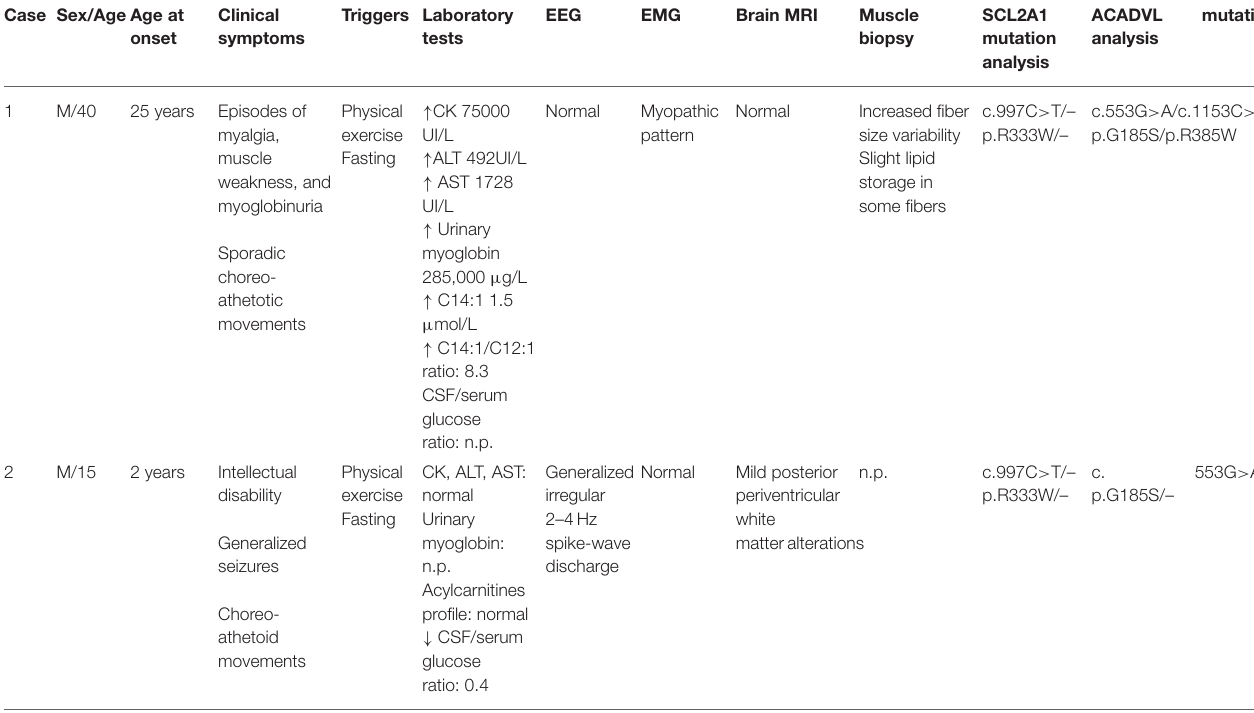
TABLE 1 | Clinical, biochemical, and genetic findings. Case Sex/Age Age at